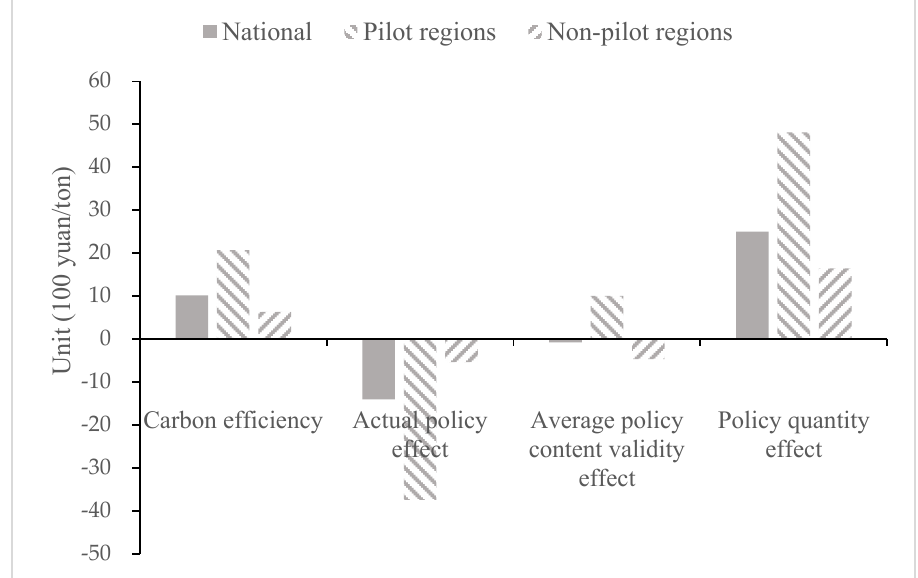
Figure 6. LMDI decomposition of carbon emissions reduction effects of CET policies across time (2015 and 2017). (Note: the data supporting the figure were calculated by the authors).